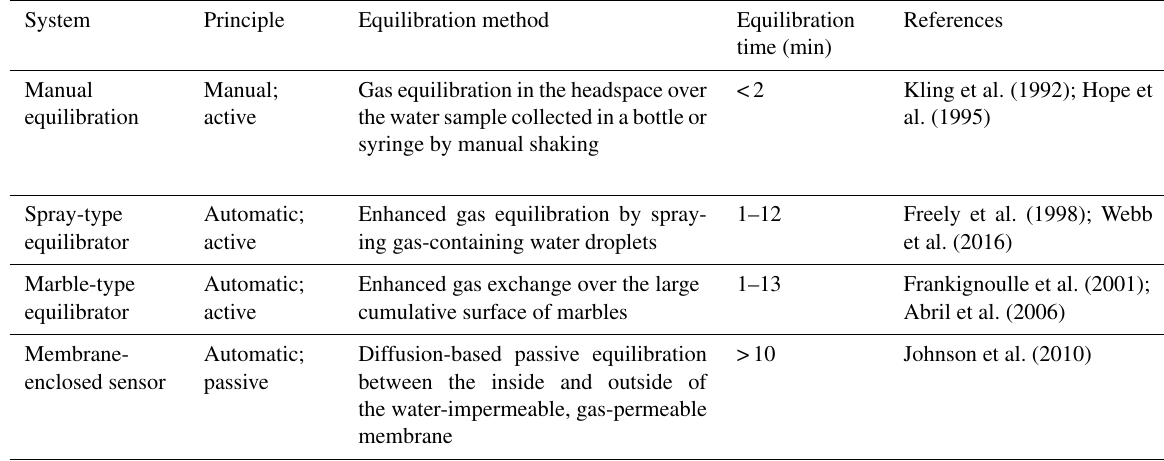
Table 1. Summary of manual headspace equilibration and three gas equilibration